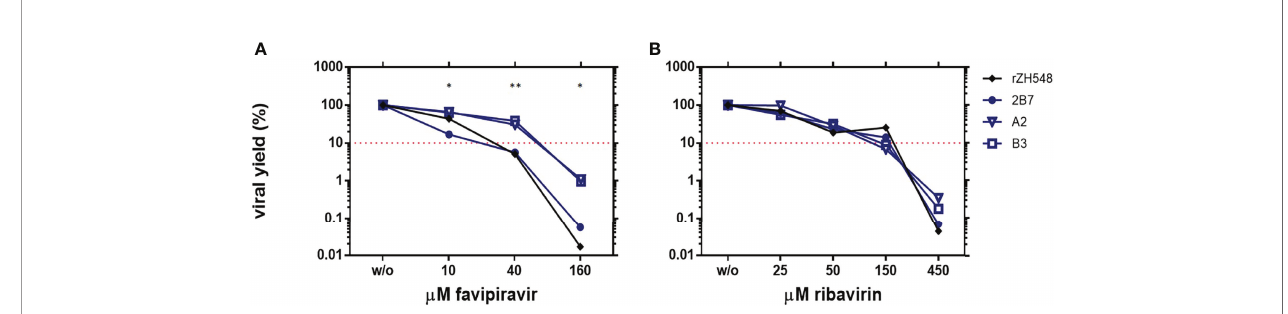
FIGURE 3 | Susceptibility of rRVFVs to mutagenic drugs in Vero cells. Reduction of viral yield in the presence of different concentrations of the mutagenic drugs favipiravir (A) and ribavirin (B) . Vero cells were infected by duplicate at a MOI of 0.1 with the rZH548_L mutant viruses under study rA2 and rB3, and also with virus 2B7 displaying the substitution NSs[P82L] also present in rA2, and with the corresponding wt virus rZH548. Supernatants were collected at 72 hpi and titrated by plaque assay, and percentages of viral titers upon treatment were calculated. Geometric mean of the values obtained in at least two independent experiments is represented. Percentages of viral yield are represented as log10 in order to highlight the differences at the highest concentrations tested. The depicted dot-line corresponds to a reduction of 90% in viral yield. For statistical analysis each L-mutant RVFV was compared to its corresponding L-wt virus: rA2 vs 2B7 and rB3 vs rZH548. *p < 0,05; **p < 0,005 (multiple T-test,